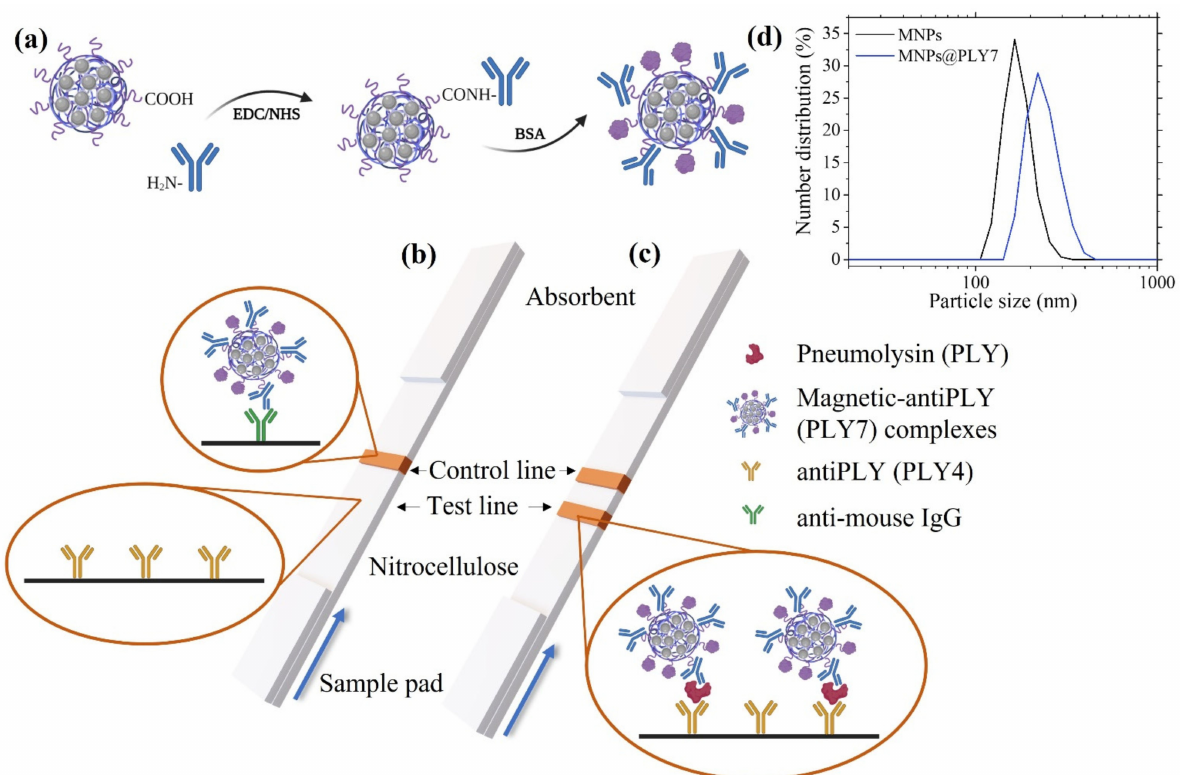
Figure 2. ( a ) Schematic illustration of the MNCs biofunctionalization with anti-pneumolysin antibody PLY7 via EDC/NHS chemistry. ( b ) Scheme of the lateral flow immunoassay, where specific antibodies against pneumolysin PLY4 (test line) and anti-mouse IgG antibodies (control line) are immobilized on the membrane. The blue arrow indicates the flow direction. In a blank sample, only the control line is visible. ( c ) Lateral flow assay for a sample containing PLY, which forms a complex with the MNCs- PLY7 and is captured at the test line by the PLY4 antibodies. ( d ) Hydrodynamic size distribution profile of the MNCs before (black) and after (blue) the bioconjugation with the PLY7